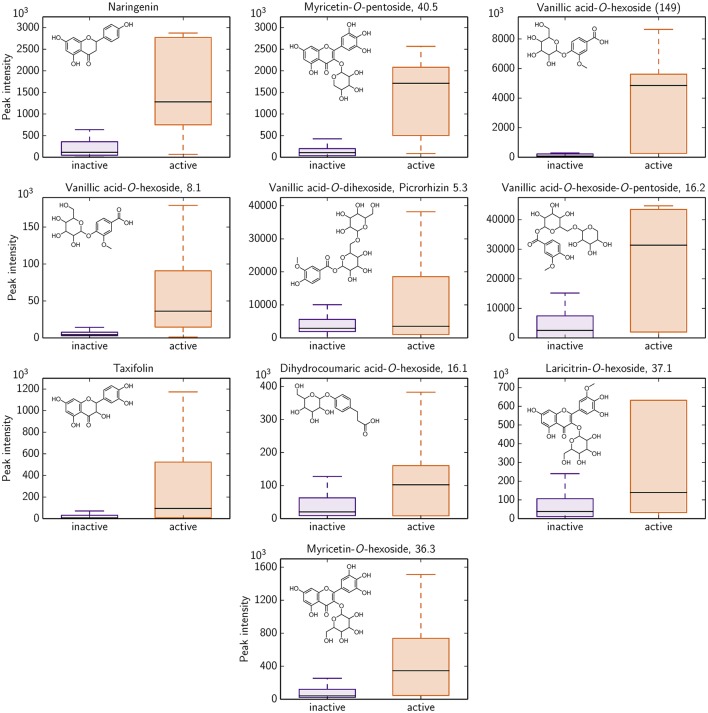
Identified polyphenolics showing significant differences in LC-MS intensity with respect to antimicrobial activity classification of all 87 Rhododendron species (remaining 282 identified compounds are provided in Figure S4). 17 species are denoted as antimicrobial active (orange), i.e., the radius of the agar diffusion assay is ≥0.6 cm, and, thus, 70 species are characterized as antimicrobial inactive (violet).